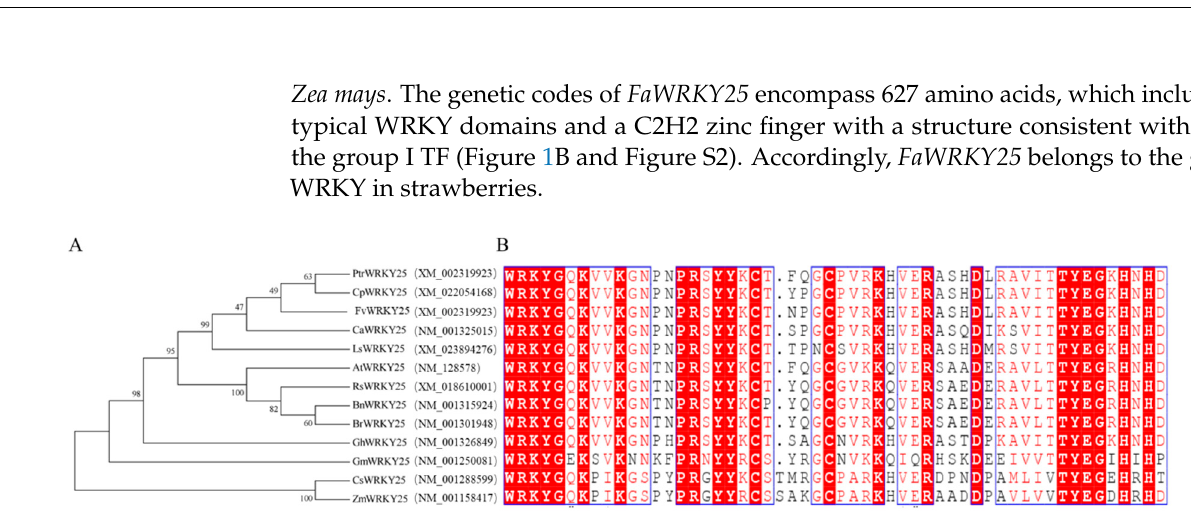
Figure 1. Phylogenetic analysis of WRKY25 protein. ( A ) Phylogenic analysis of WRKY25 homologs from various species. Species name abbreviations are follows: At, Arabidopsis ; Br, Brassica rapa ; Rs, Raphanus sativus ; Bn, Brassica napus ; Gh, Gossypium hirsutum ; Gm, Glycine max ; Cs, Camelina sativa ; Zm, Zea mays ; Ls, Lactuca sativa ; Ca, Capsicum annuum ; Cp, Carica papaya ; Ptr, Populus trichocarpa . ( B ) Sequence alignment of the deduced amino acid sequences of WRKY25. The gene accession numbers are found in Table S2.